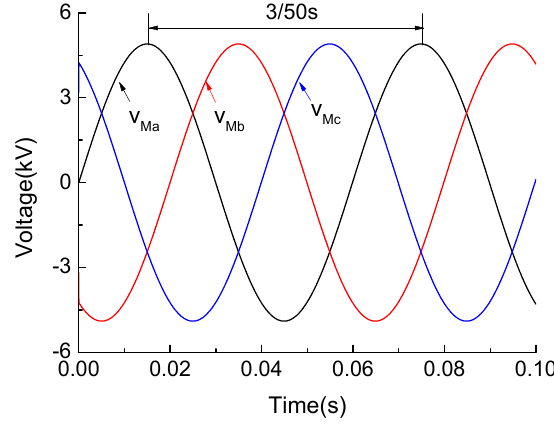
Figure 2. System voltage waveforms.